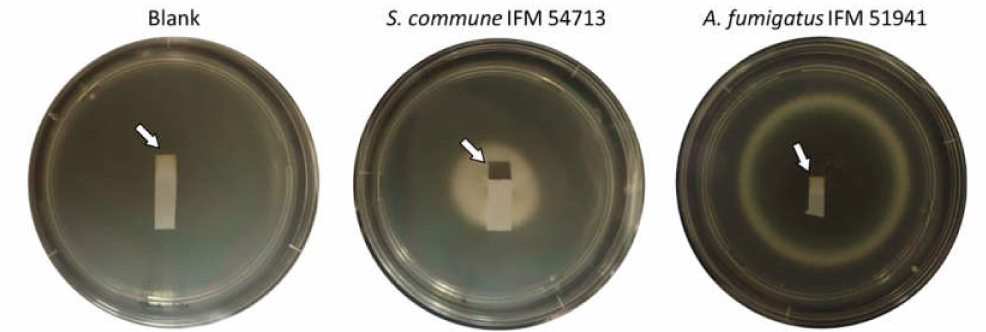
Figure 4. Detection of H 2 S using lead acetate paper. Lead acetate paper appearance exposed in a non-inoculated plate ( left ) and to VOCs from S. commune IFM 54713 ( middle ) and A. fumigatus IFM 51941 ( right ) for three days under 35 ◦